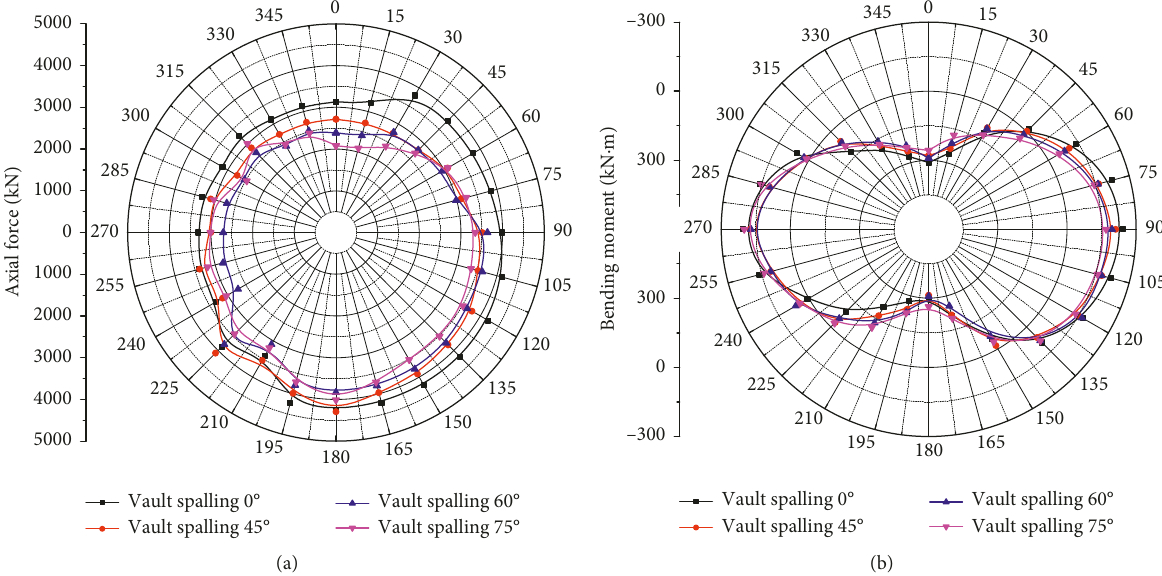
Figure 12: Segment circumferential internal force diagram at elastic-plastic demarcation. (a) Segment circumferential axial force diagram. (b) Segment circumferential bending moment diagram.